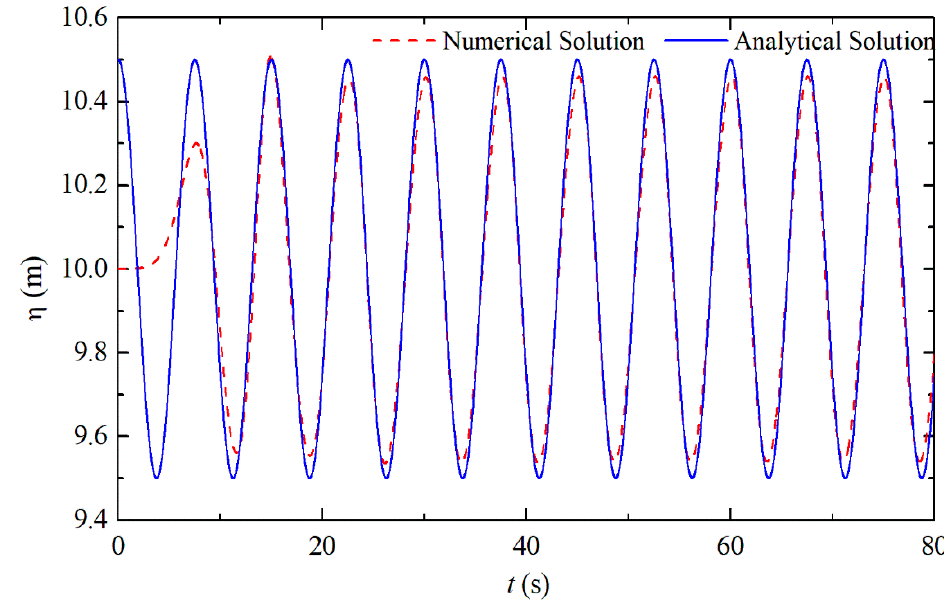
Figure 5. Comparison of the numerical and analytical solution of water surface level in the wave channel.